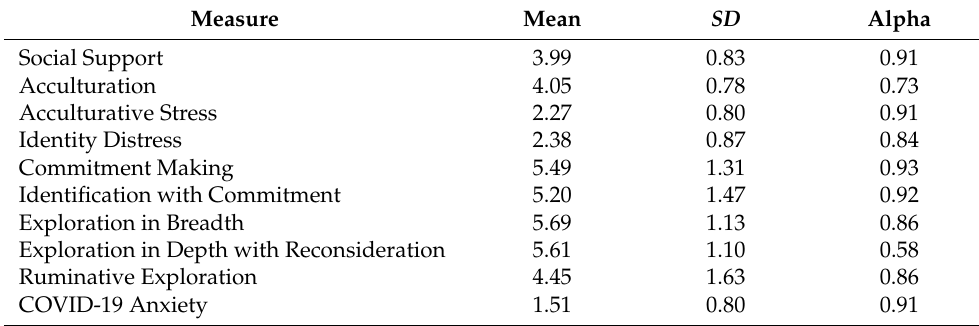
Table 1. Means, standard deviations, and alphas for all study